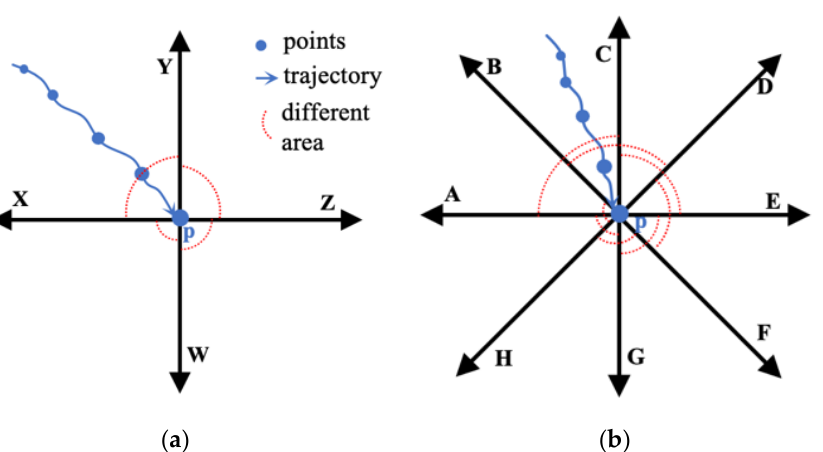
Figure 3. DP-TBD in different areas. For each pixel, ( a ) DP process in 4 areas; ( b ) DP process in 8